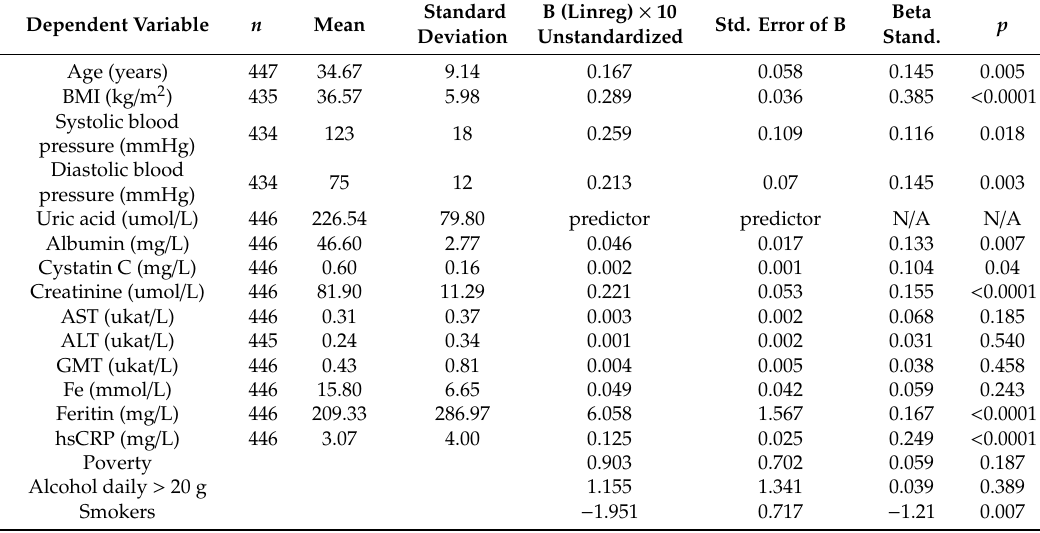
Table 3. Relationship between uric acid adjusted for age and sex and dependent variables in the Roma subgroup.